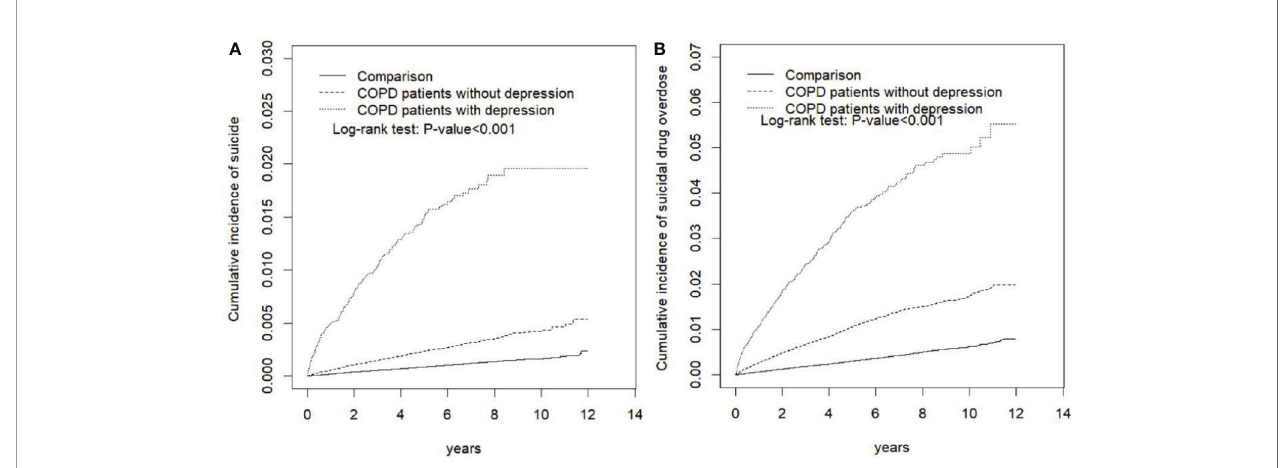
FIGURE 1 | Comparison of the Cumulative Incidence of (A) Suicide Attempt and (B) Suicidal Drug Overdose Among COPD Patients With Depression, COPD Patients Without Depression, and the Normal Population. COPD, chronic obstructive pulmonary